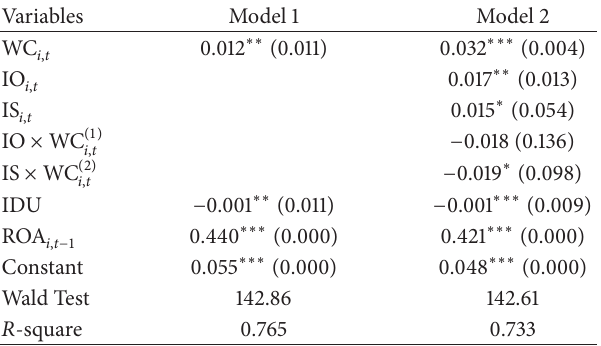
Table 7: Distribution of working capital ratio. Table 8: Influence of working capital on performance in different